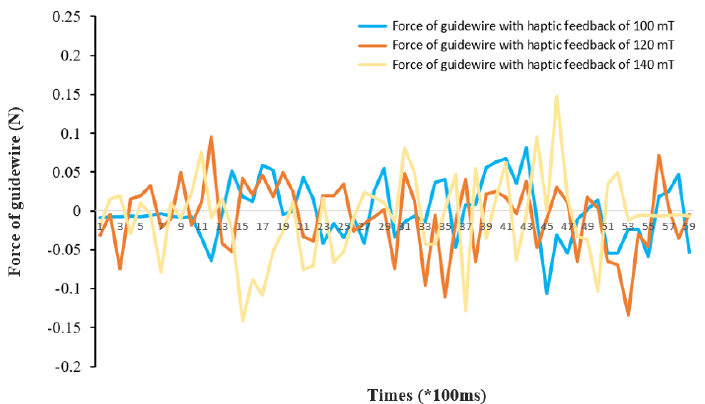
Figure 17. Quantitative experimental result with different levels of force feedback.